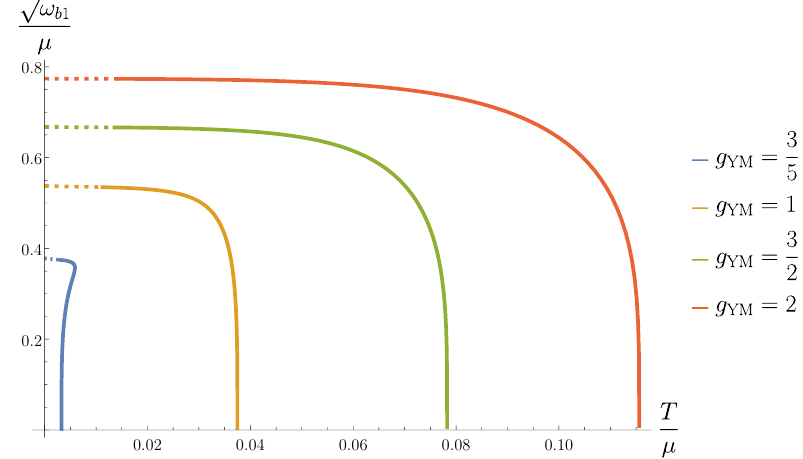
Figure 3. Phase diagrams for the four values of g YM considered. The g YM = 1 , 3 / 2 and 2 curves all exhibit similar behaviour, while the g YM = 3 / 5 curve becomes multi-valued between certain temperatures. This indicates that a critical value, g c , exists and from inspection is g c = YM YM 0 . 8075 ± 0 . 0025 . Below g c there are first order phase transitions, whilst above g c there will be YM YM second order transitions. This can be confirmed by studying the grand potential and entropy. The dashed part of the curves represent extrapolation of the data to reach zero